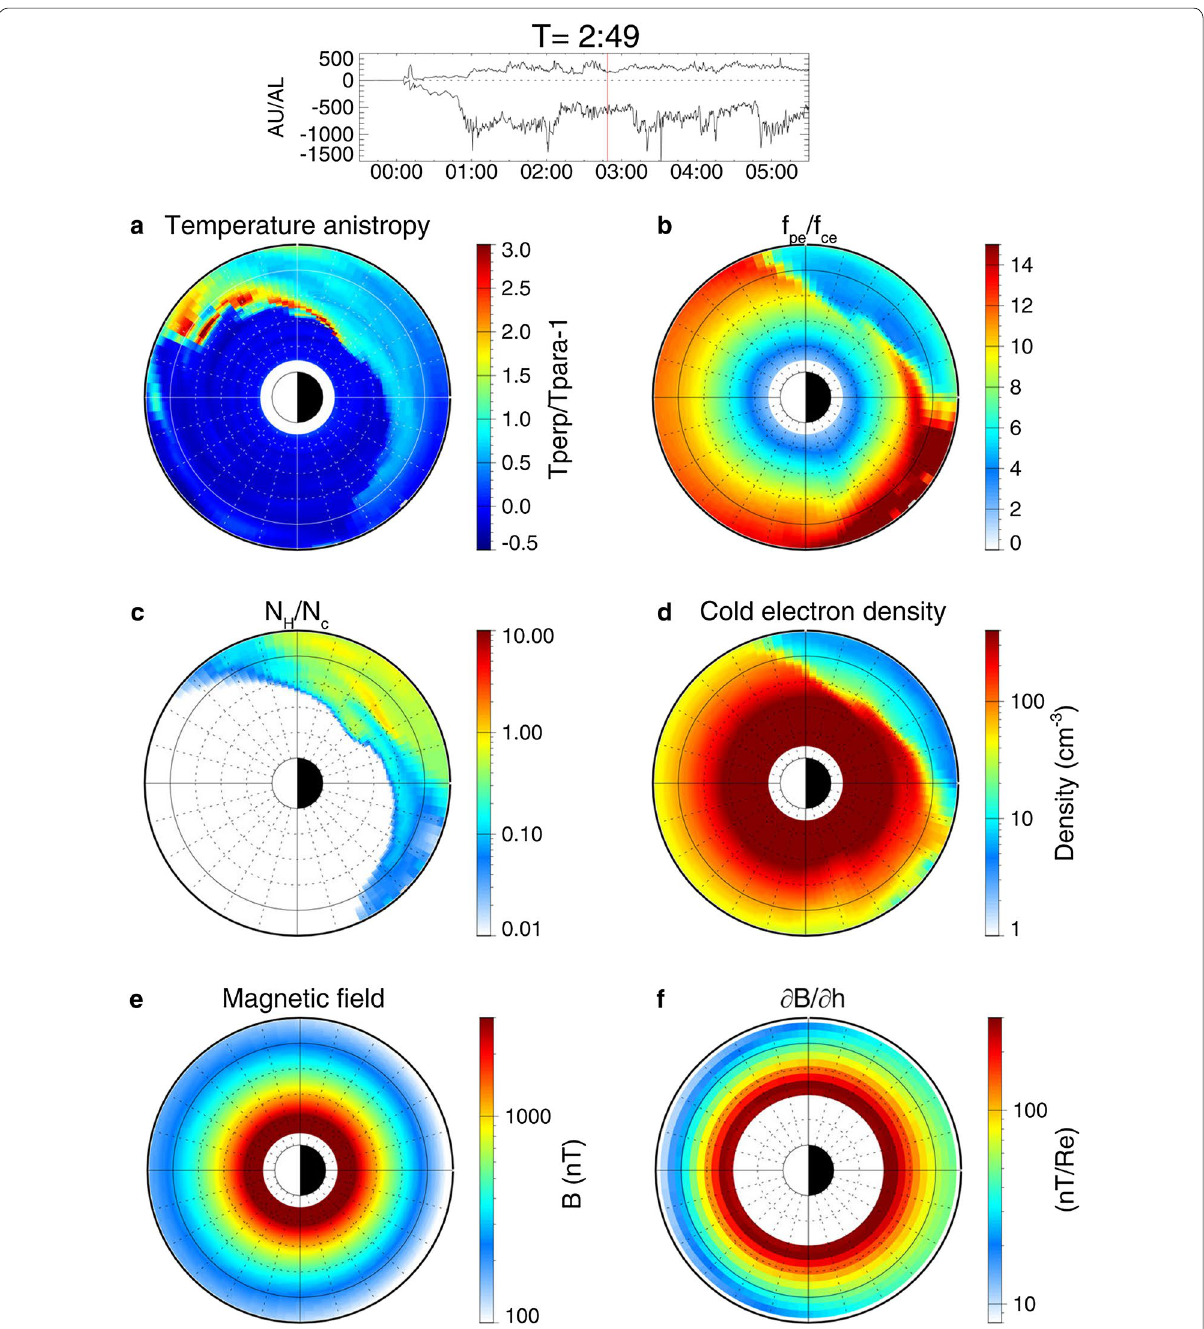
Fig. 4 a Temperature anisotropy ( T / T 1, where T and T are the perpendicular and parallel temperature), b the ratio between the electron ∥ − ∥ ⊥ ⊥ plasma frequency ( f pe ) and the electron cyclotron frequency ( f ce ), c the ratio between the hot electron density ( N H ) and the cold electron density ( N c ), d the cold electron density in the equatorial plane, e the magnitude of the magnetic field, and f the gradient of the magnetic field along a field line at T 169 min (2:49). The Sun is to the =